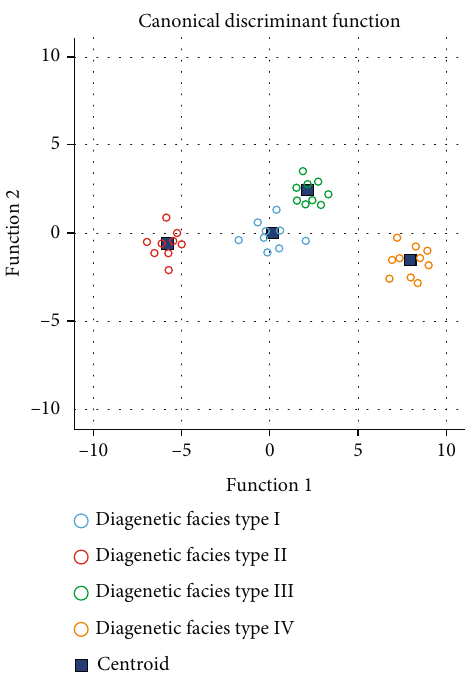
Figure 11: Distribution of the centroids of the four types of diagenetic facies